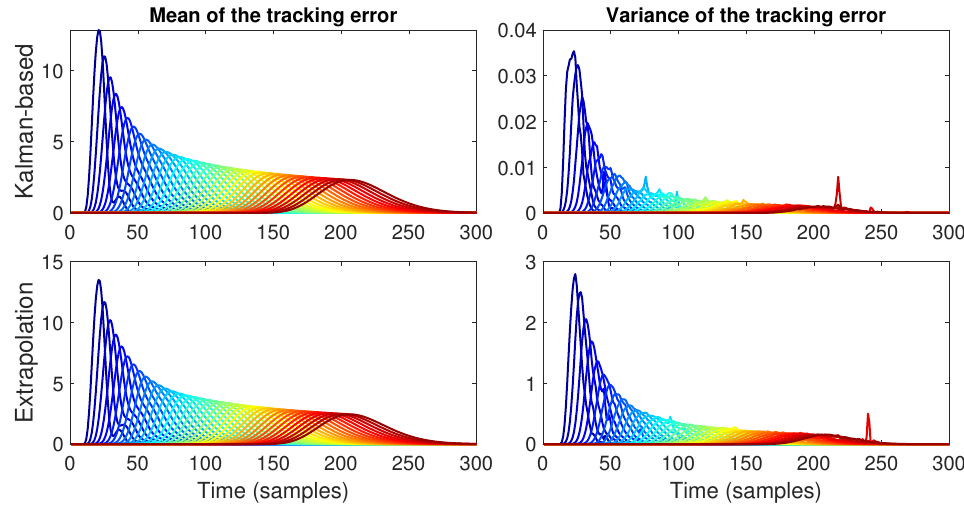
( k ) and variance σ 2 ( k ) of the tracking error for p = 0.75. In this case, the peak Figure 15. Mean µ ζ ζ i i variance value of the Kalman strategy increases to 0.03, whereas the variance of the extrapolation strategy also increases to a peak value close to 3.